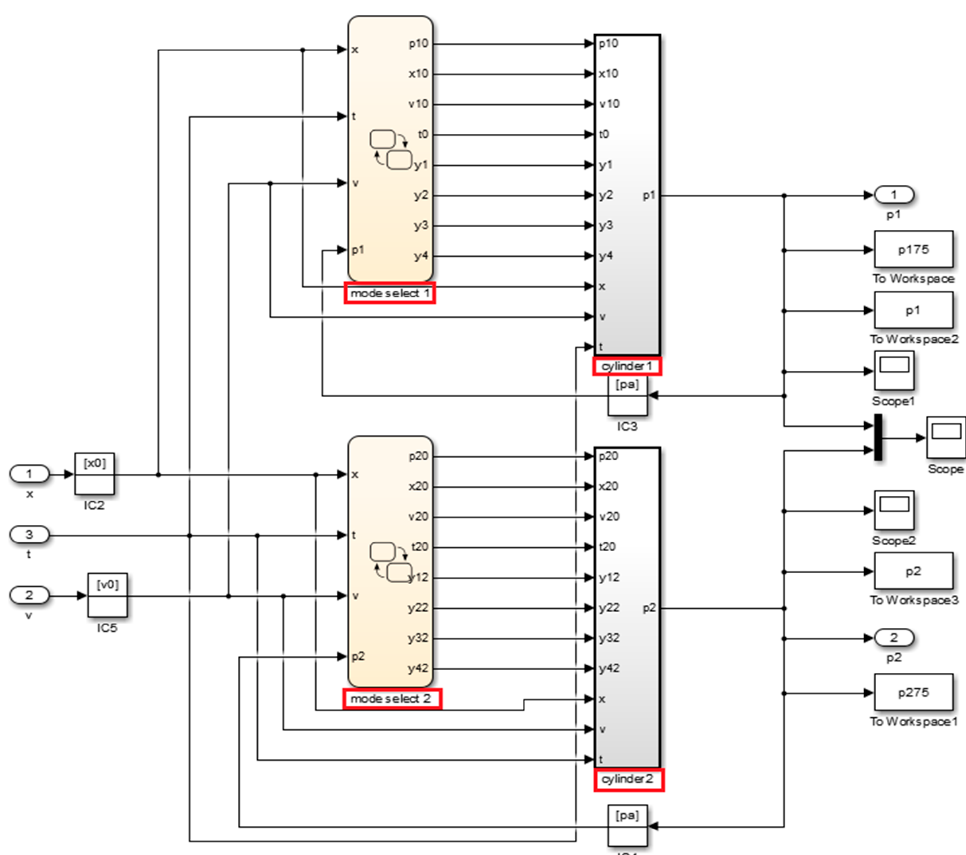
Figure 5. Block diagram of the “engine” sub ‐ model.